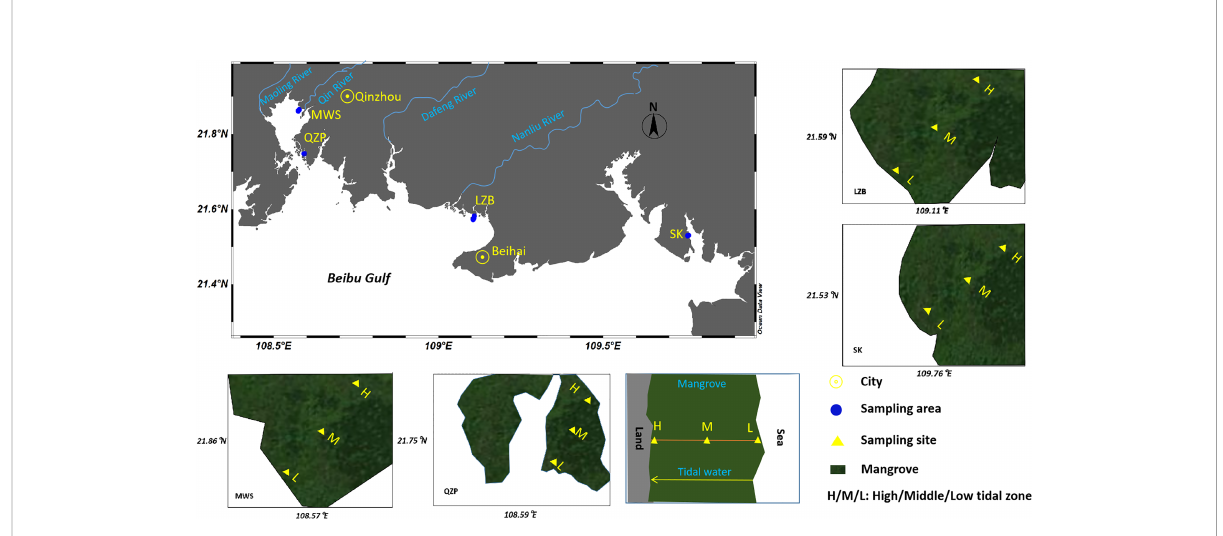
FIGURE 1 Map of mangrove sampling sites. (Note: the yellow triangles represents low, middle and high tidal sampling sites in each intertidal